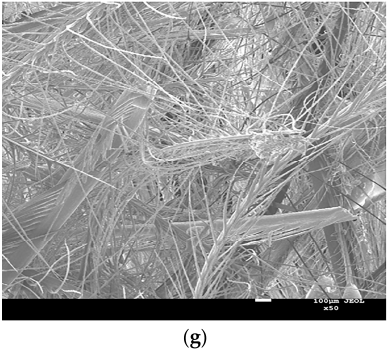
Figure 9. SEM images of samples (#1–7) surface morphology ( a – g ).